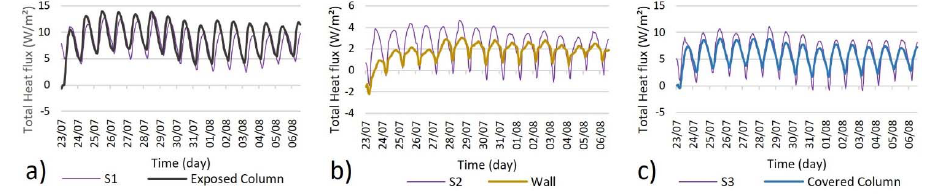
Figure 12. Simulated total heat flux result for two weeks for ( a ) exposed column, ( b ) wall, and ( c ) covered column, shown in relation to experimentally monitored data for different sensor locations S1–S3. Table 4. Results of statistical evaluation error comparison between experimental data and simulated data.